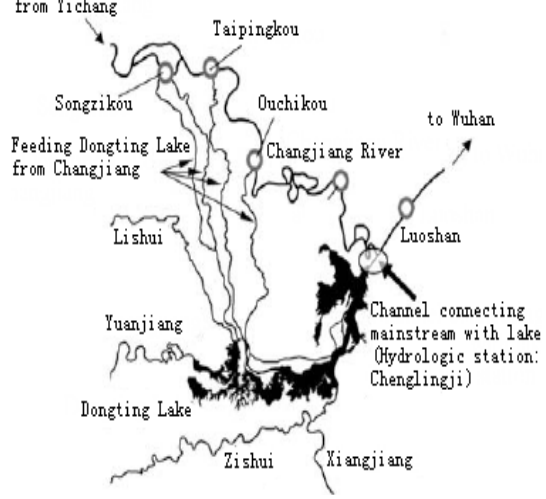
Fig. 4. The relationship between the Dongting Lake area and the Fig.4. The relationship between the Dongting Lake area and Changjiang River Changjiang River.